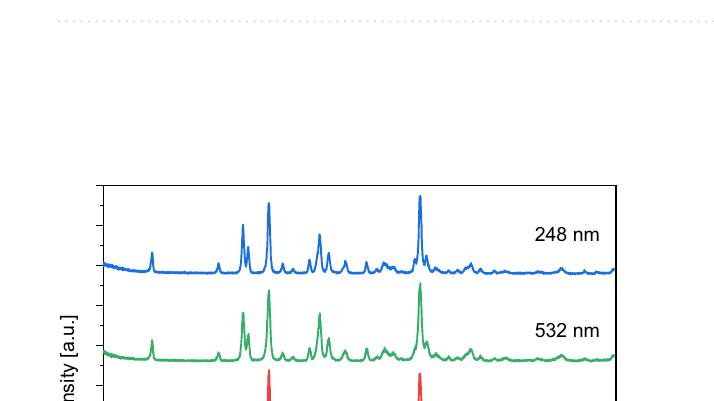
Figure 5. The chemical structure and ion mass of (a) meloxicam and (b) meloxicam impurity B. (c) The relative peak areas of meloxicam impurity B compared to meloxicam [(Area Impurity /Area Meloxicam ) × 100%] and (d) the meloxicam concentrations (determined by HPLC–MS method) in case of the investigated wavelengths (248 nm, 532 nm, 1064 nm).